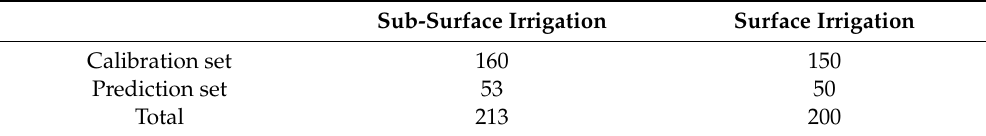
Table 2. Number of samples per irrigation technique for calibration and prediction